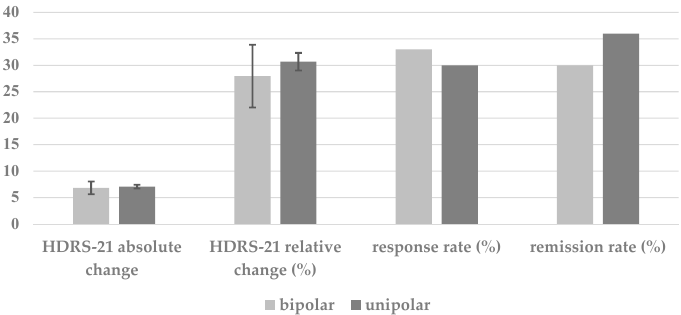
Figure 1. Absolute HDRS-21 change (in amount) and relative HDRS-21 change, response rate and remission rate (in percentages) for bipolar and unipolar depressed patients.